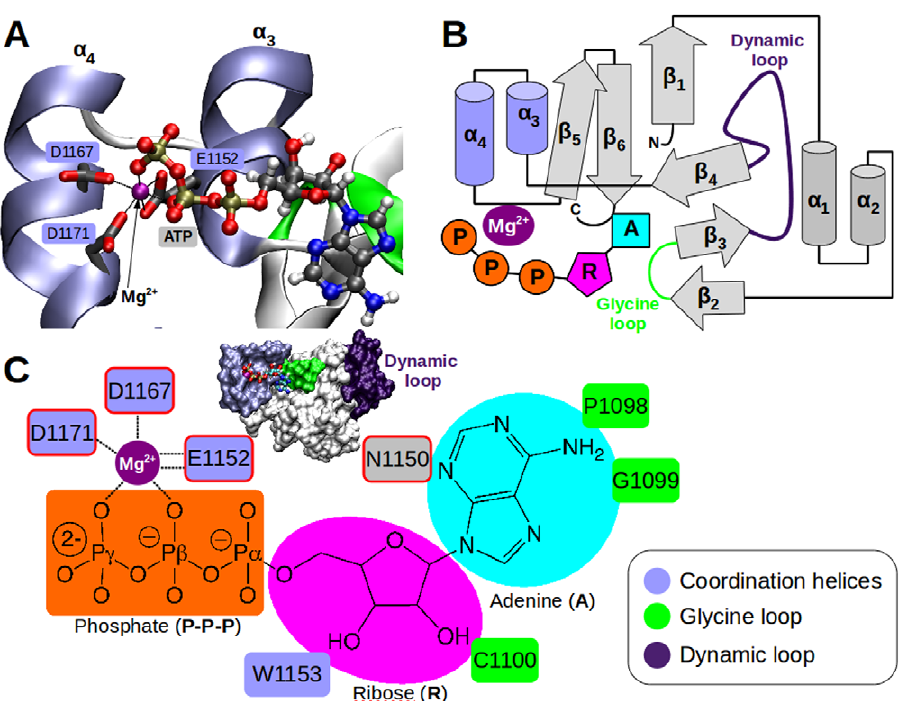
Figure 2. Mg 2 + -ATP coordination site within the N-domain (WT-Mg-ATP complex). (A) The surface of the protein is displayed with the main regions implied in interactions with ATP that are colored following the internal text label. A close view of the binding pocket is presented with a 3 / a 4 helices (light blue) in ribbon representation with amino acid side-chains and ATP, with Mg 2 + ion (purple sphere), in ball and stick representation. Carbon, oxygen, nitrogen, and phosphorous atoms are colored in gray, red, nitrogen, and orange, respectively. (B) Topological diagram of the secondary structures of the N-domain. Cylinders and arrows represent a -helices and b -strands, respectively. The nucleotide is shown with three different parts: Adenine (blue), Ribose (magenta) and Phosphate tail groups (orange). For illustration, glycine and dynamic loops are colored in green and purple, respectively. (C) 2D representation of the singular amino acids involved in direct interaction with magnesium ion or ATP atoms. Amino acids framed in red have been mutated (see Experimental